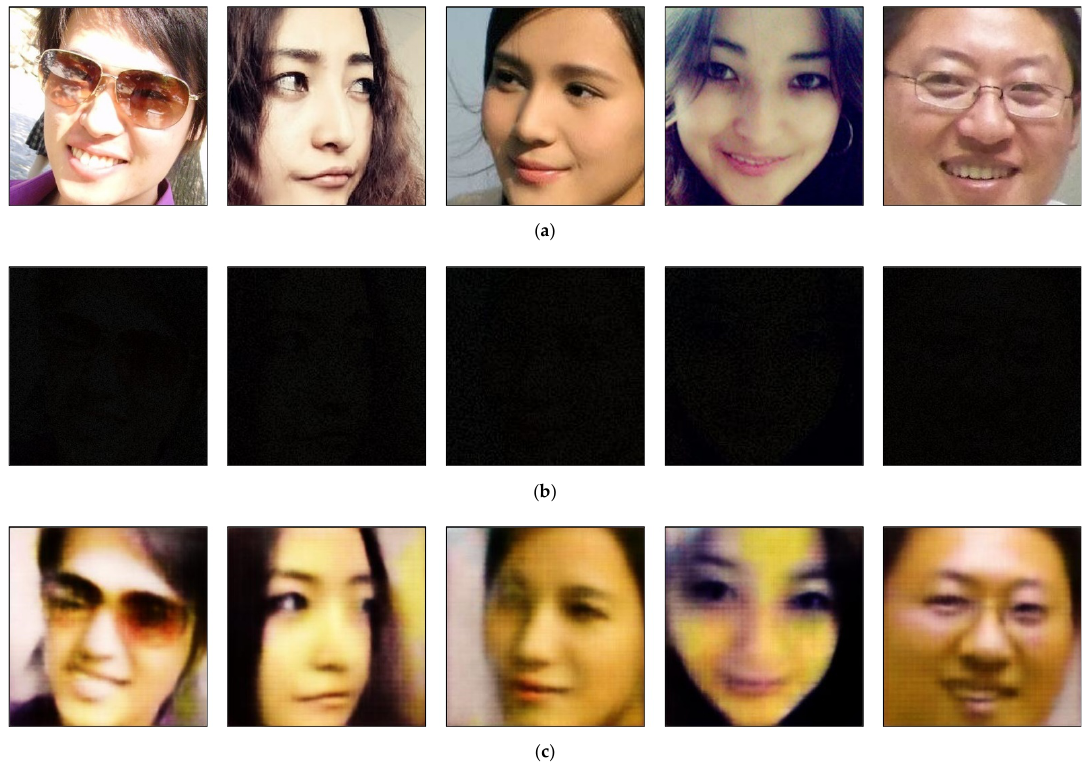
Figure 15. Various angles and illumination images in the AFAD database. ( a ) is the original database, ( b ) is the low-illumination images, and ( c ) is the images enhanced with LAE-GAN. In addition, gradient-weighted class activation mapping (Grad-CAM) [87] images extracted from each layer of DEX, with the images enhanced using LAE-GAN as input, were analyzed. Figure 16a is the original facial image, while the pictures on the left and right sides in Figure 16b are low-illumination images and the images enhanced by LAE- GAN, respectively. Figures 16c through 16g are Grad-CAM images extracted from the first, fourth, eighth, and eleventh convolutional layers and the last max pooling layers. The pictures on the left in Figure 16c–g are Grad-CAM images, while the pictures on the right are the LAE-GAN-enhanced images overlapped with the Grad-CAM images.